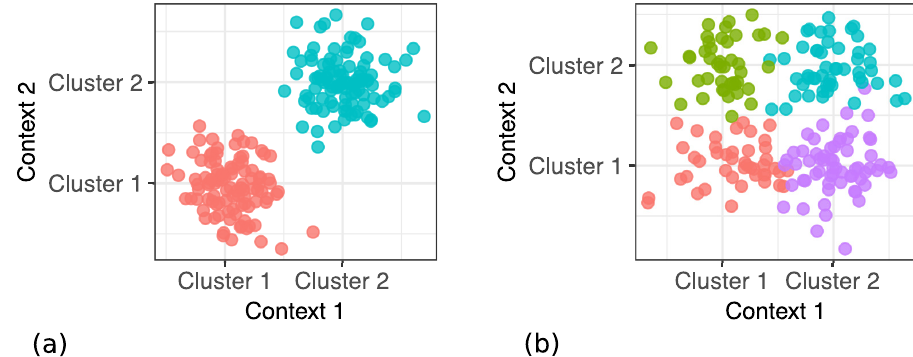
Fig 2. Example of the simulated data for p = 0 and p = 0.5, which show different degrees of dependence. The x axis corresponds to the data in the first dataset (context), the y axis representsthe data in the second dataset (context). The two subfigures show the two extreme situations: (a) For p = 0, we get two globalclusters. Cluster membership is fully dependent on each other in both datasets. (b) For p = 0.5, we get four globalclusters, where cluster membershipin one dataset is fully independent on cluster membershipin the second